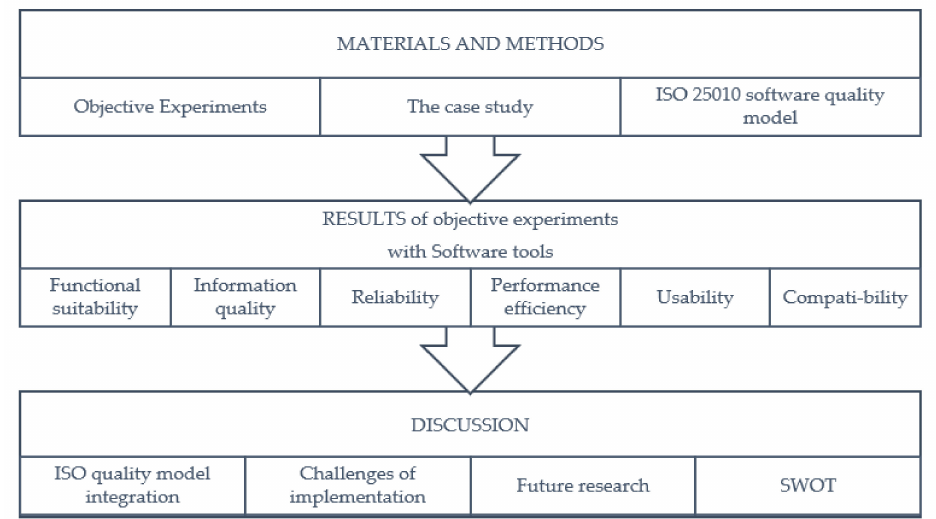
Figure 1. Structure of the paper (source: